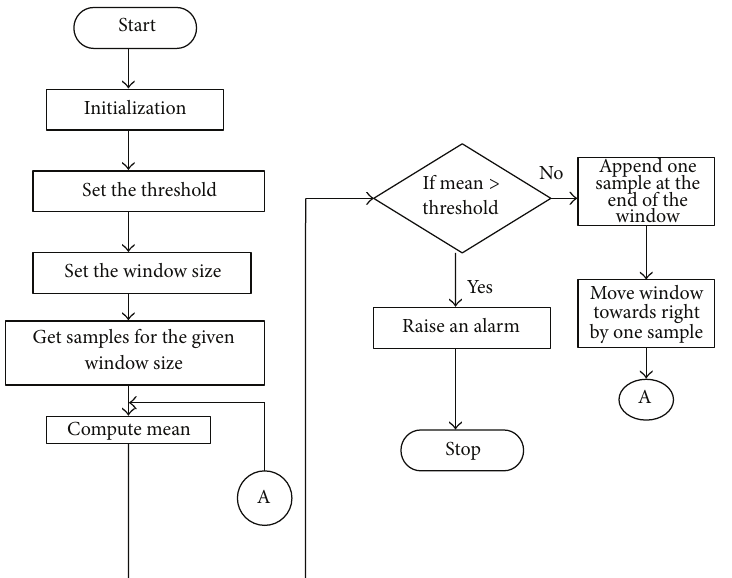
Figure 2: Illustration of the procedure to detect change in the mean